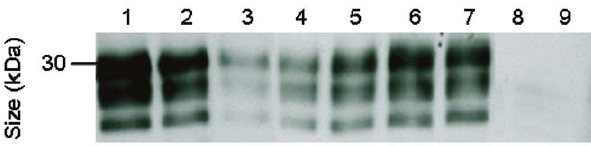
Figure 2. Detection and semi-quantitative assessment of PrP TSE in skeletal muscles of CWD-infected WTD. Western blot detection of PrP27-30, the Proteinase K-resistant core of PrP TSE , after labelling with anti-PrP monoclonal antibody ICSM-18. Lanes 1–3, PrP TSE extracts from 100 mg of skeletal muscle from an uninfected control WTD (blotted also in lane 9) spiked before extraction with 1 6 10 2 4 g (lane 1), 5 6 10 2 5 g (lane 2), and 1 6 10 2 5 g of CWD brain tissue from a WTD in the clinical stage of disease. Lanes 4–8, PrP TSE extracts from 100 mg samples of the following muscles from CWD-infected WTD: M. glutaeobiceps (farmed animal Fa-WTD 8, lane 4), M. semimembranosus/ tendinosus (farmed animal Fa-WTD 1, lane 5), M. semimembranosus/ tendinosus (hunter-kill animal FR-WTD 1, lane 6), M. semimembranosus/ tendinosus (hunter-kill animal FR-WTD 2, lane 7), M. semimembranosus/ tendinosus (farmed animal Fa-WTD 2, lane 8). Lane 9, extract from 100 mg sample of M. glutaeobiceps from an uninfected control WTD (Fa-WTD 10). doi:10.1371/journal.pone.0018345.g002 PLoS ONE |